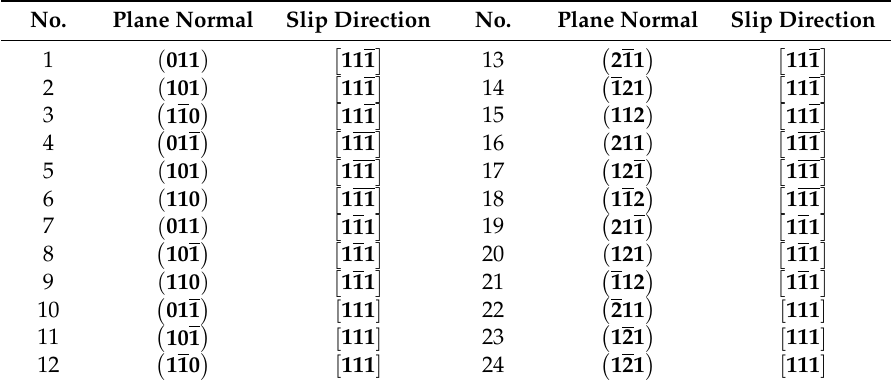
Table 1. 24 {110} <111> and {112} <111> slip systems for bcc crystal.